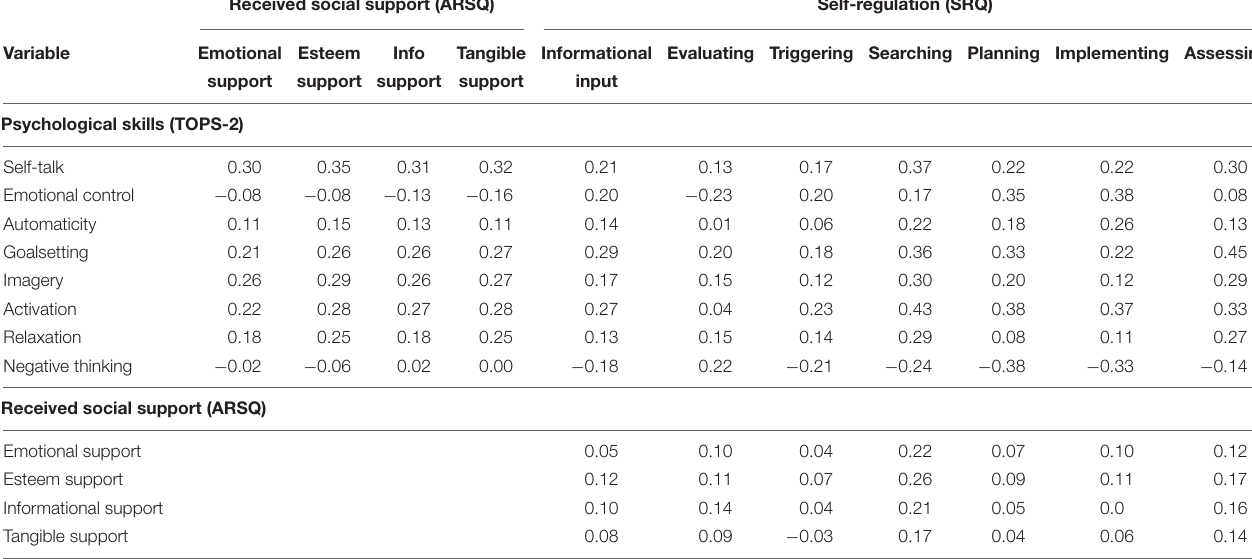
TABLE 4 | Pearson product moment correlations between study variables.